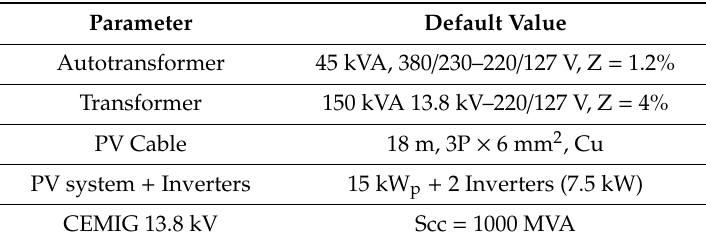
Figure 3. One-line diagram for the PV System of the Center of Excellence in Smart Grids situated in UNIFEI’s campus (Federal University of Itajubá) [4,31,32]. Table 1. Parameters of the CERIn System [4,31,32].